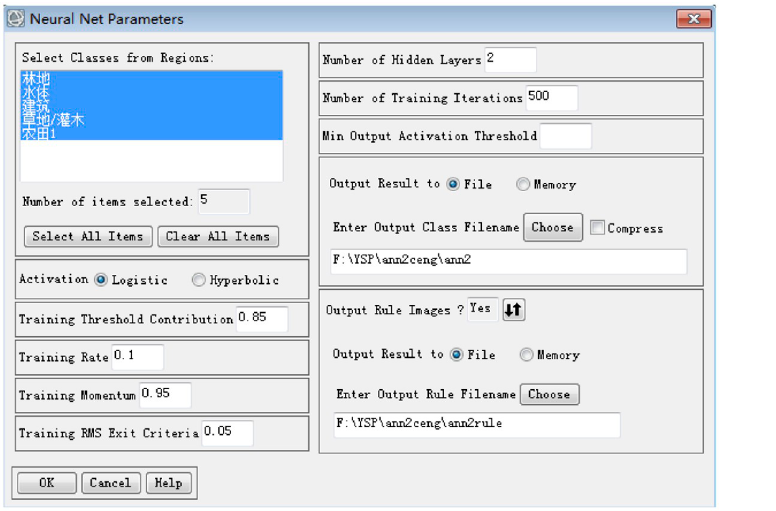
Fig 9. NN parameter